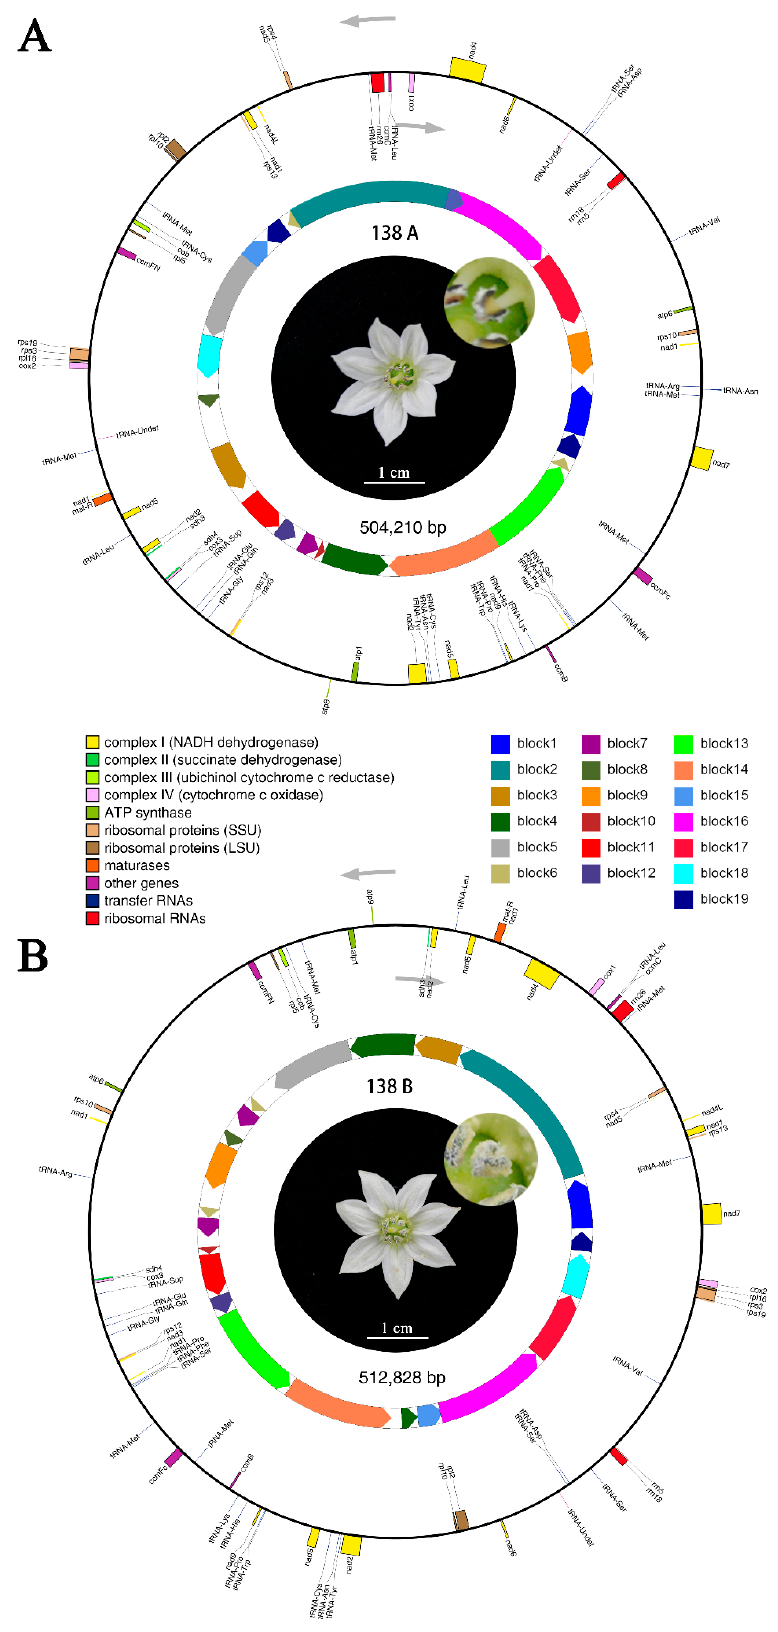
Figure 1. Mitochondrial genome maps of sterile line 138A and maintainer line 138B. ( A ) Mitochondrial genome map of 138A. ( B ) mitochondrial genome map of 138B. Genes with the names inside the circle